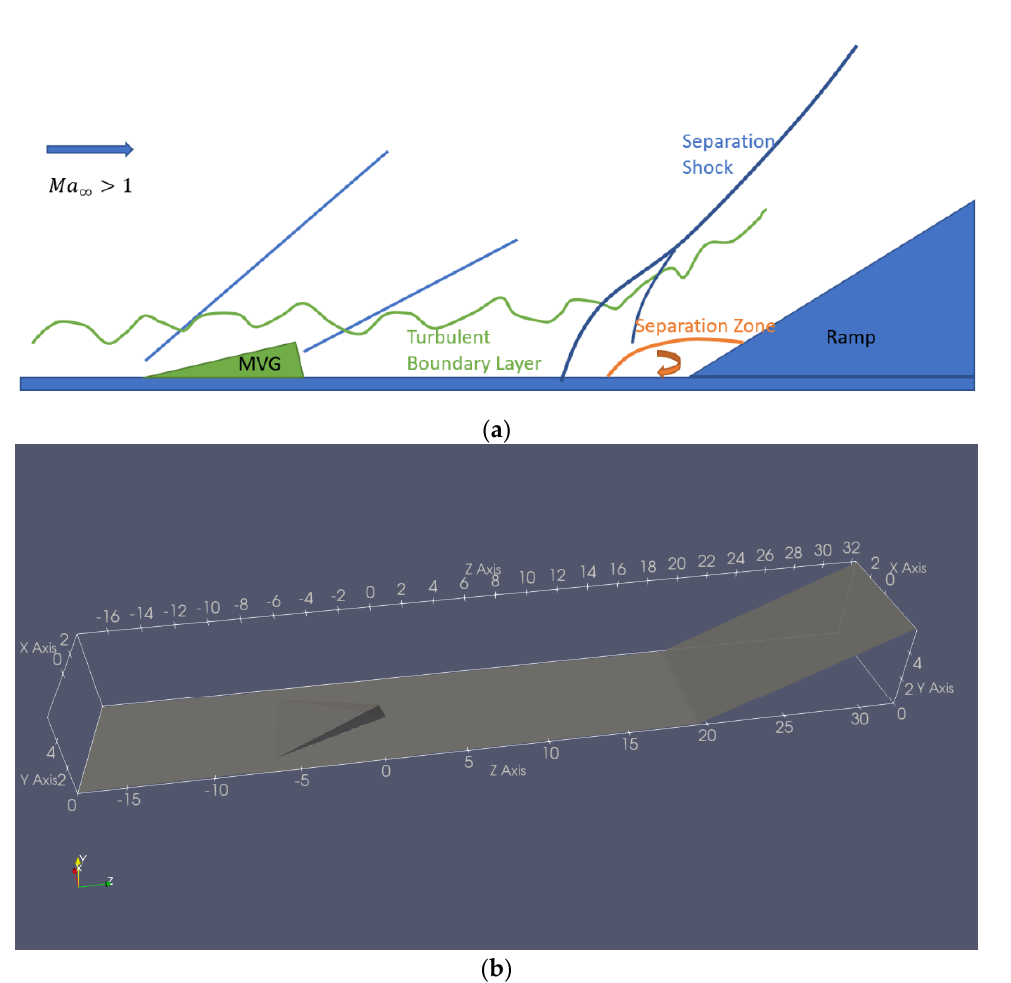
Figure 1. The illustration of the flow field ( a ) and the domain with MVG installed on the wall boundary ( b ).